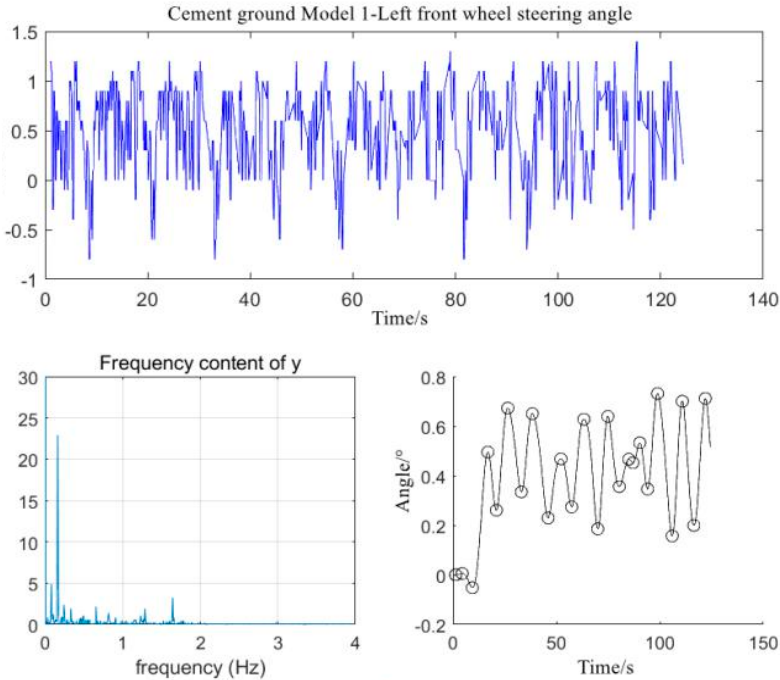
Figure 8. Analysis data of the left front wheel steering angle in mode 1.